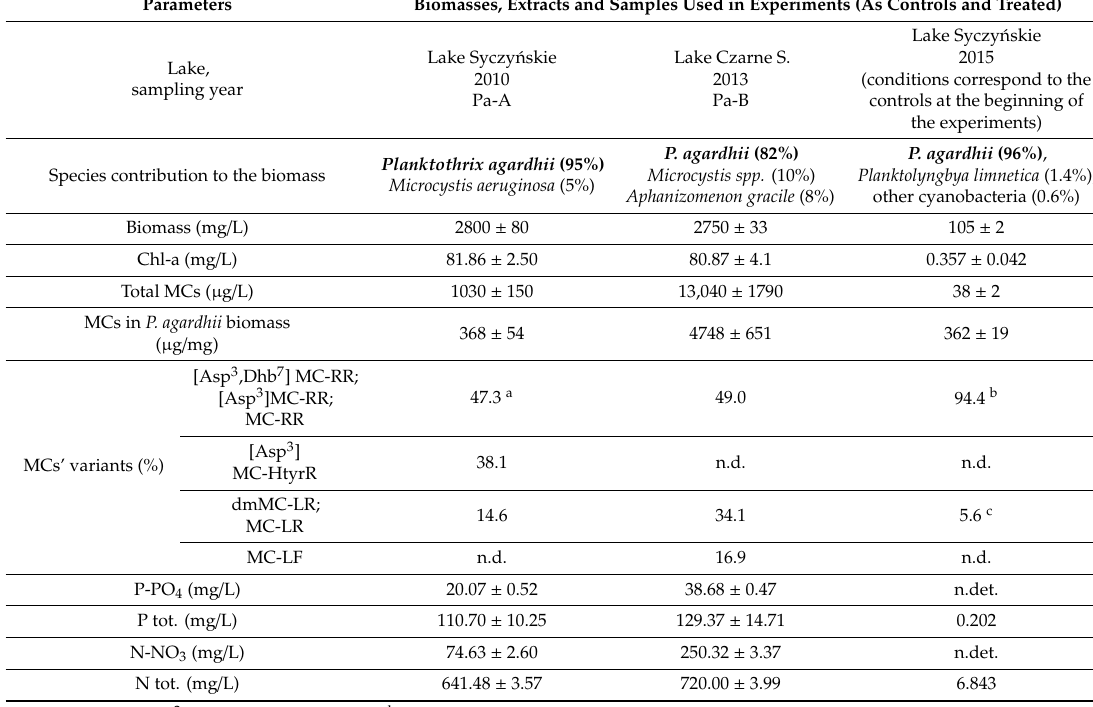
Table 1. Characteristics of two di ff erent Planktothrix -dominated scum samples, their crude extracts (Pa-A, Pa-B) and the phytoplankton sample with P. agardhii used in the experiments. Data are expressed as means ± SD ( n =